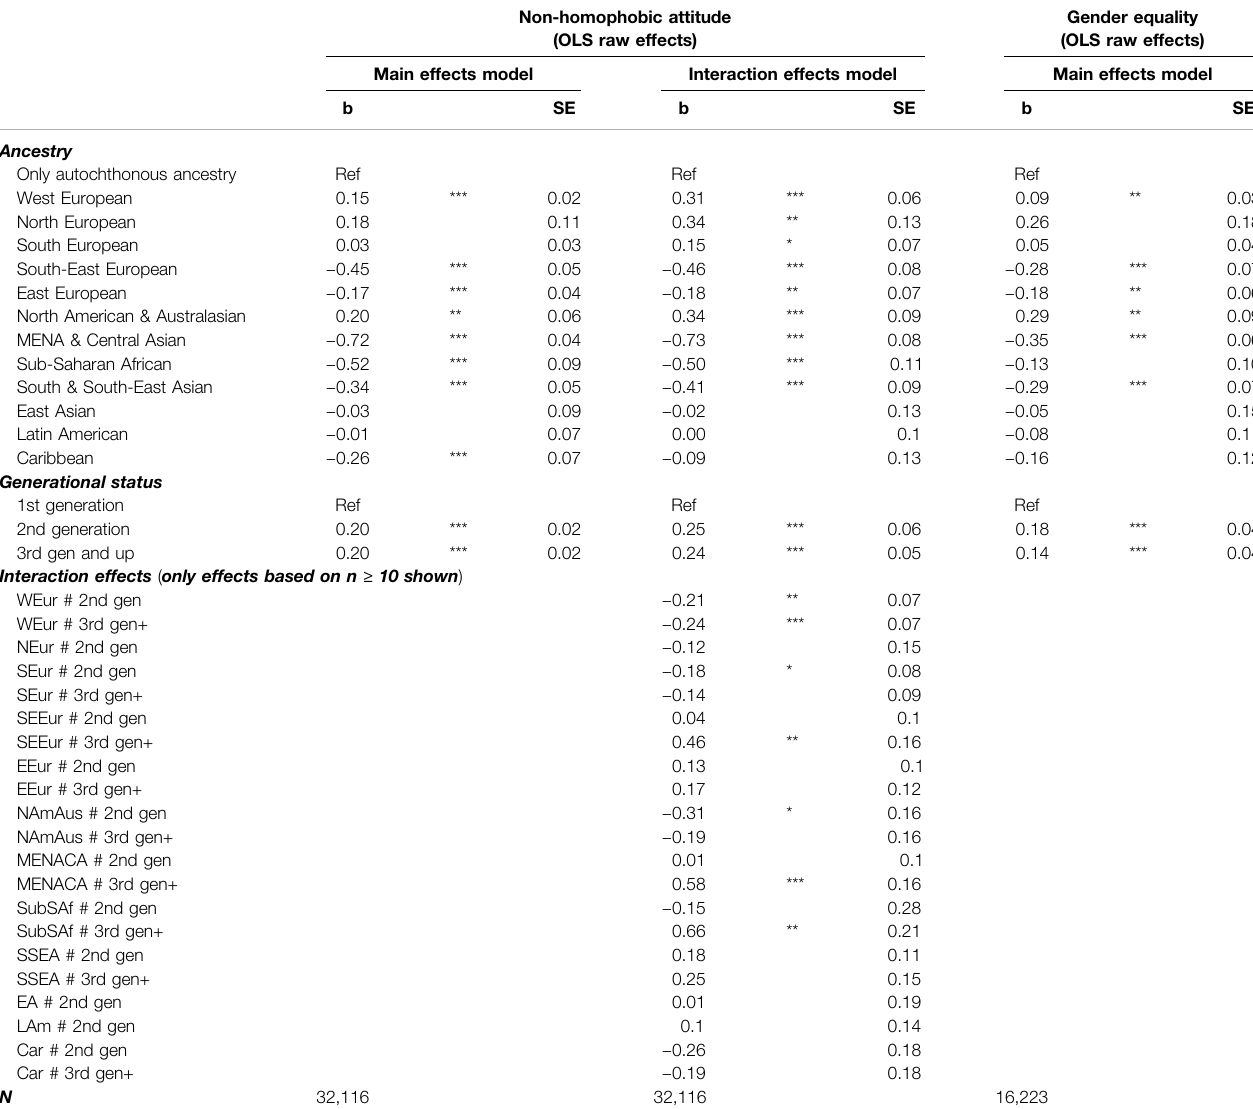
TABLE 6 | Regression models for cultural integration (gender equality in ESS8